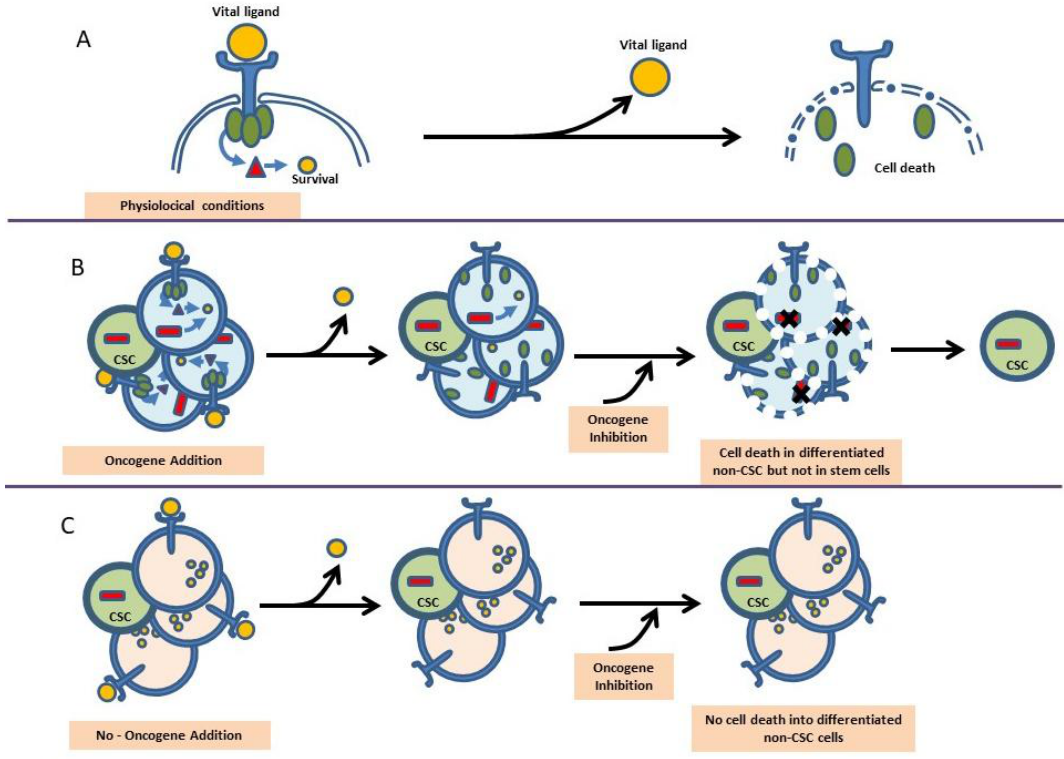
Figure 1. Oncogene addition versus reprogramming cancer predisposition. ( A ) In physiological conditions, the survival of a cell is determined by a specific survival pathway that needs to be activated by a vital ligand recognized by a specific receptor. If this vital ligand is removed from the niche/environment, the cell will die. ( B ) The oncogene addition hypothesis implies that a tumoral cell is able to grow independently of the survival signals because the oncogene activates survival pathways that maintain the tumor cell alive without vital ligands in the niche. The oncogene addition model implies that the inhibition of the oncogene in the tumor cells leads to the tumor cell death, as the survival pathways are no longer active. But under this scenario the evidence from the clinic indicates that only non-CSCs die. ( C ) The tumor reprogramming model of cancer initiation suggests that tumor stem cells are not oncogene addicted because there is a different function for oncogenes within CSCs. In this model, the target cancer cell of origin is not addicted neither to the oncogenes nor to the environmental signals.